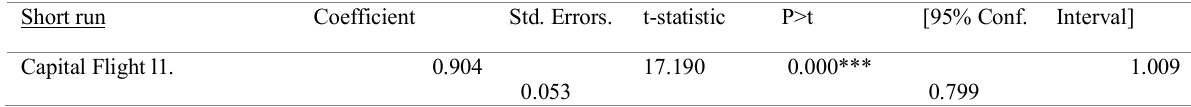
Table 11: Regression results for lagged capital flight on capital flight Short run Coefficient Std. Errors. t-statistic P>t [95% Conf. Interval] Capital Flight